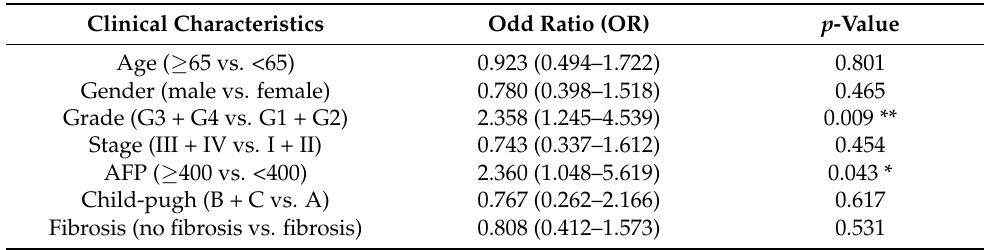
Table 1. Logistic regression assessment of RGS20 expressions between the clinical variable groups using TCGA data. Clinical